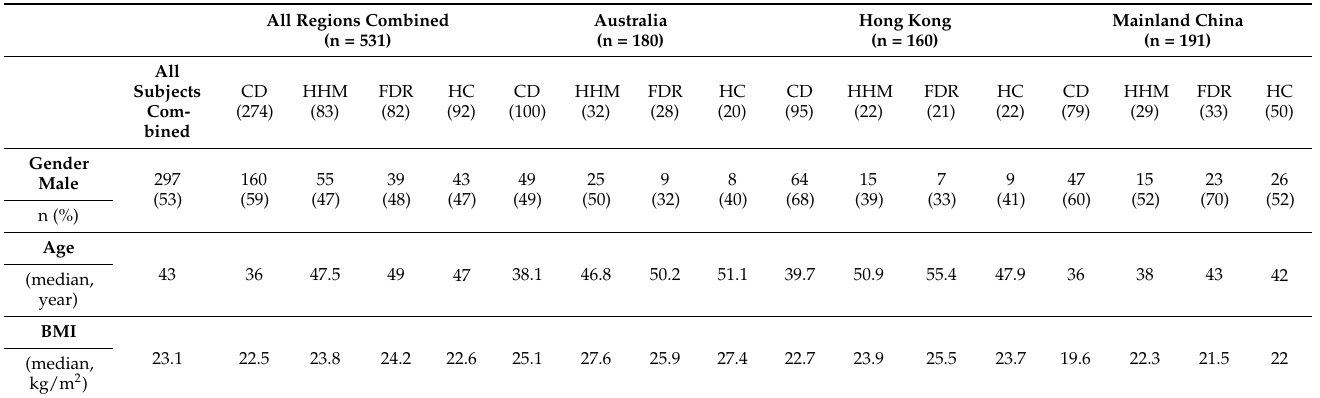
Table 1. Patient